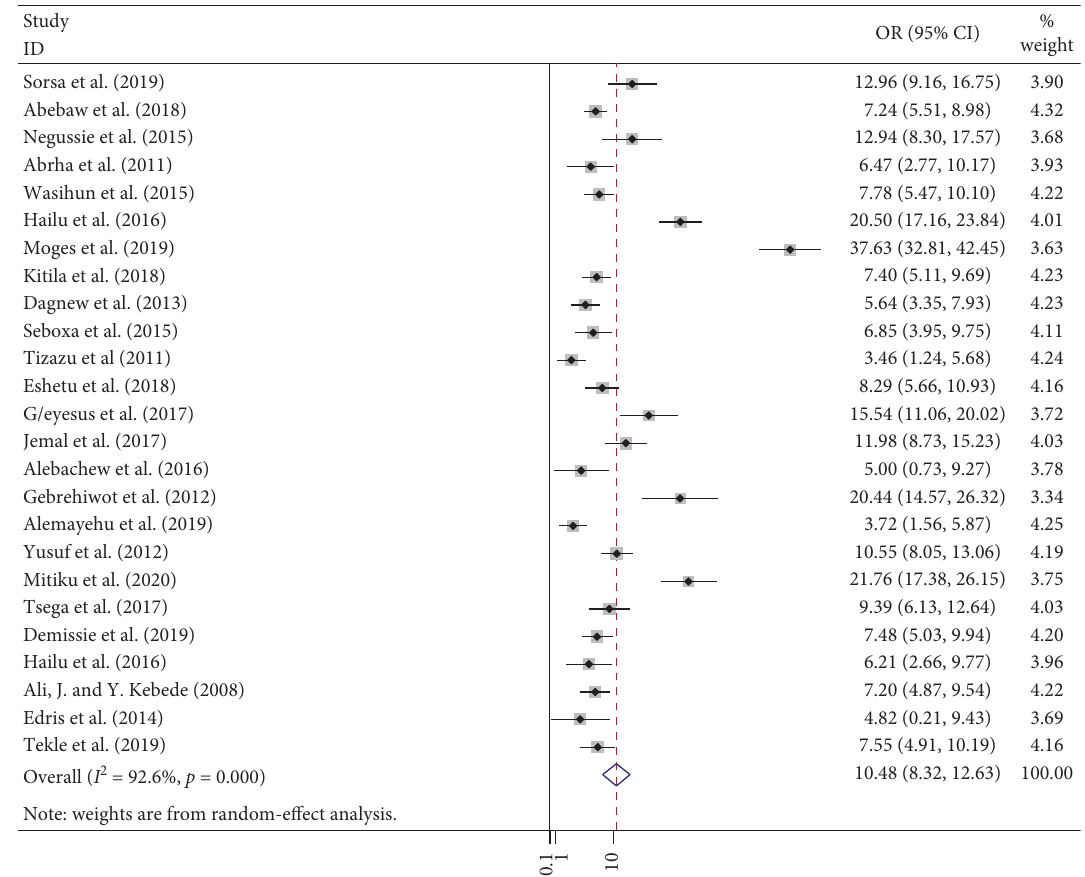
Figure 4: Forest plot showing the pooled prevalence of Gram-negative bacterial isolates among patients with suspected bloodstream infections in